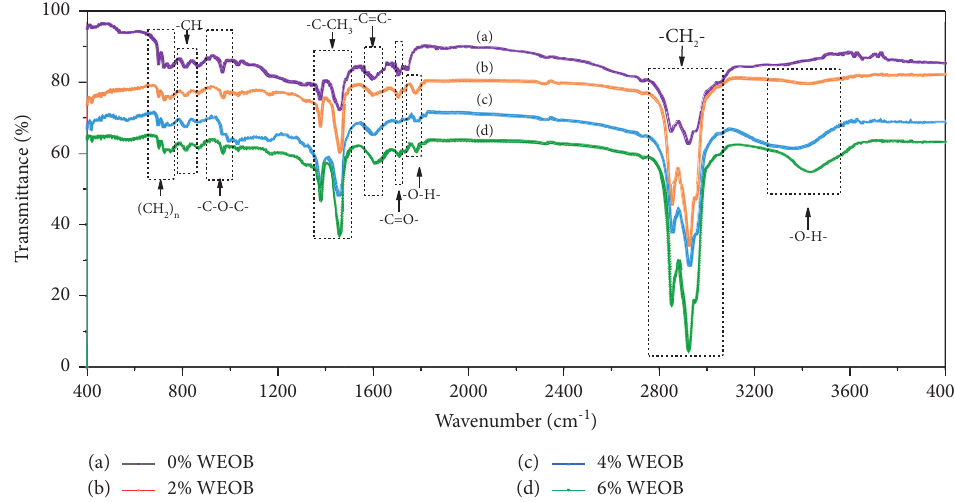
Figure 13: FTIR of WEOB-modified asphalt.